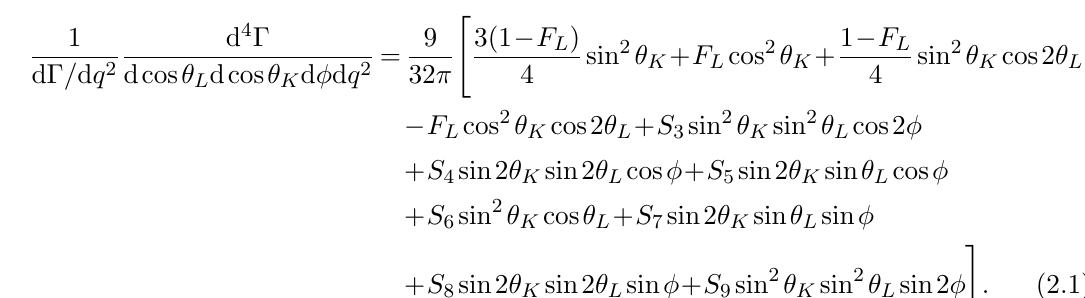
Figure 1 . An illustration of the B 0 in the text. Angles are computed in the rest frame of the K